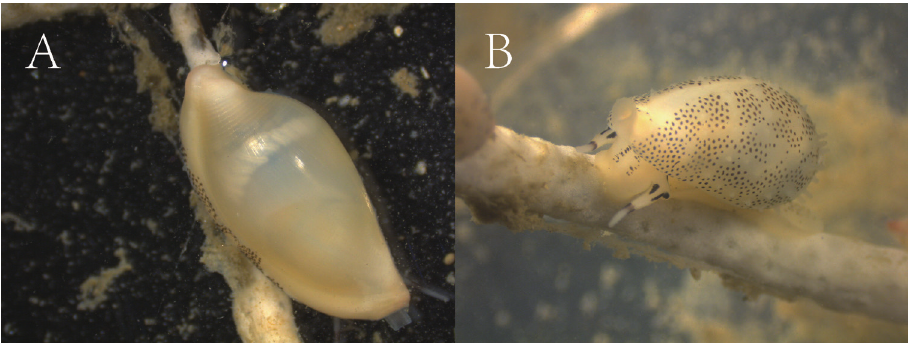
Figure 2. Living animals of Sandalia bridgesi Lorenz, 2009 A sample 20201117H19 B sample